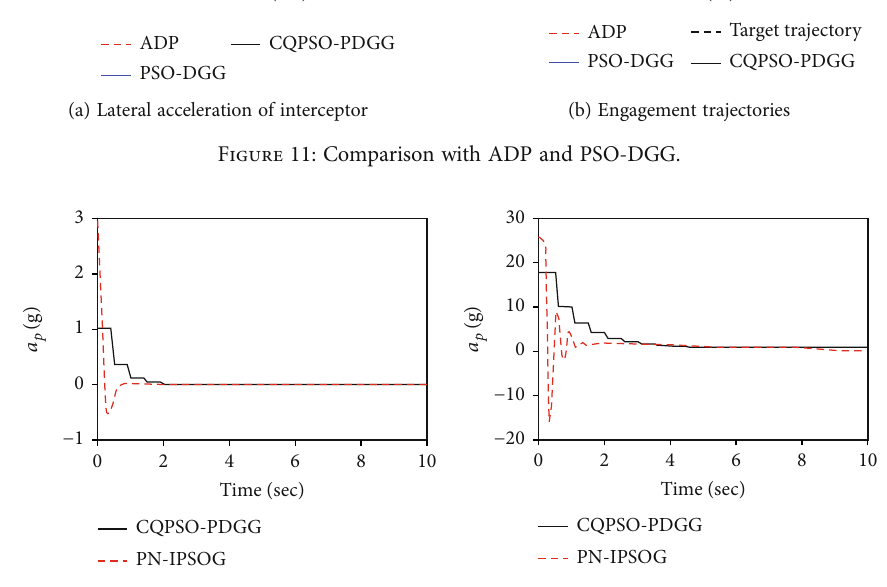
Figure 12: Comparison with PN-IPSOG in the presence of step target